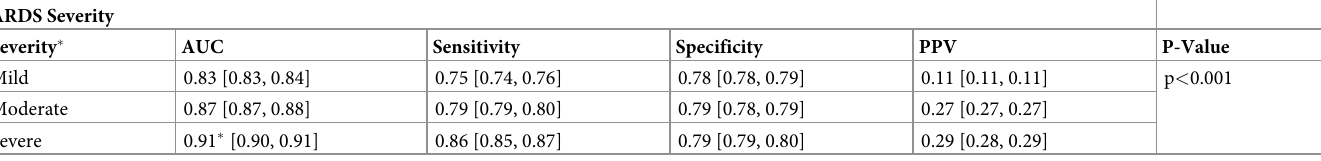
Table 3. Analysis of model performance on the hold-out dataset against ARDS